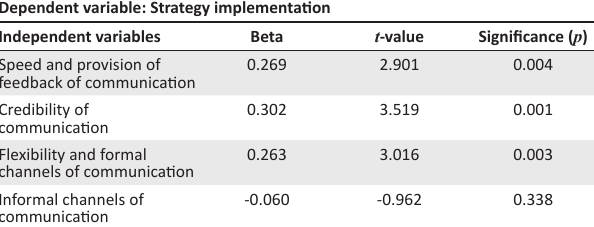
TABLE 2: Multiple regression results. Dependent variable: Strategy implementation Independent